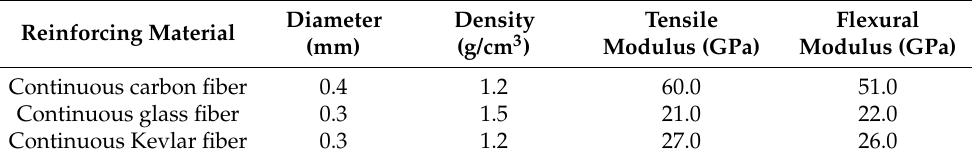
Table 1. Material parameters of the CFRPF at MarkForged company.